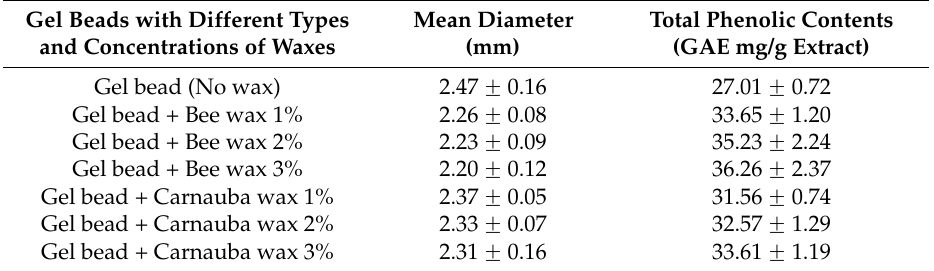
Table 3. Effect of the types and concentrations of waxes on the mean diameter and total phenolic content of emulsion gel beads containing tamarind seed